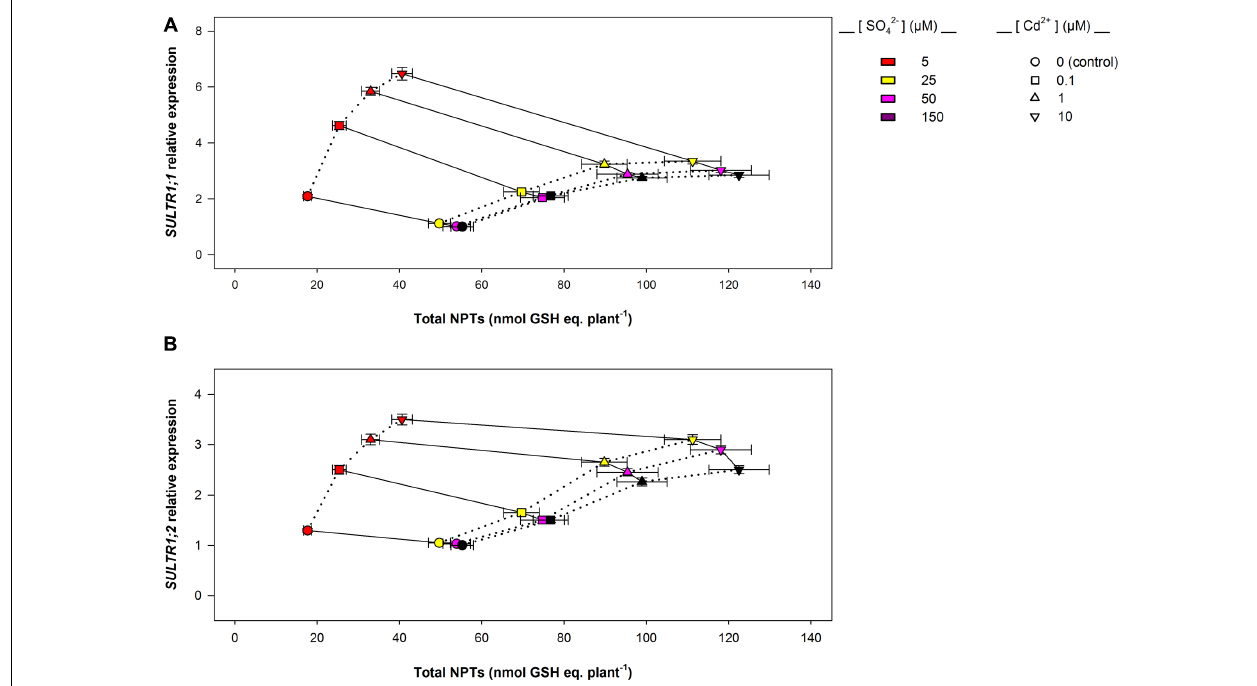
FIGURE 8 | SULTR1; 1 (A) and SULTR1; 2 (B) relative expression vs. total NPT levels per plant: short-term exposure. The relationships between the relative expression of SULTR1; 1 or SULTR1; 2 transcript and the total amount of NPTs per plant were evinced using data reported in Figure 3 and Supplementary Figure S4. Solid lines link data about plants exposed to the same Cd concentration (circles, 0 µ M Cd 2 + ; squares, 0.1 µ M Cd 2 + ; triangles up, 1 µ M Cd 2 + ; triangles down, 10 µ M Cd 2 + ), under different sulfate availabilities. Dotted lines link data about plants grown under the same sulfate concentration in the absence or presence of different Cd 2 + concentrations. Data reported in each plot are means and SE of two experiments run in triplicate ( n = 6).